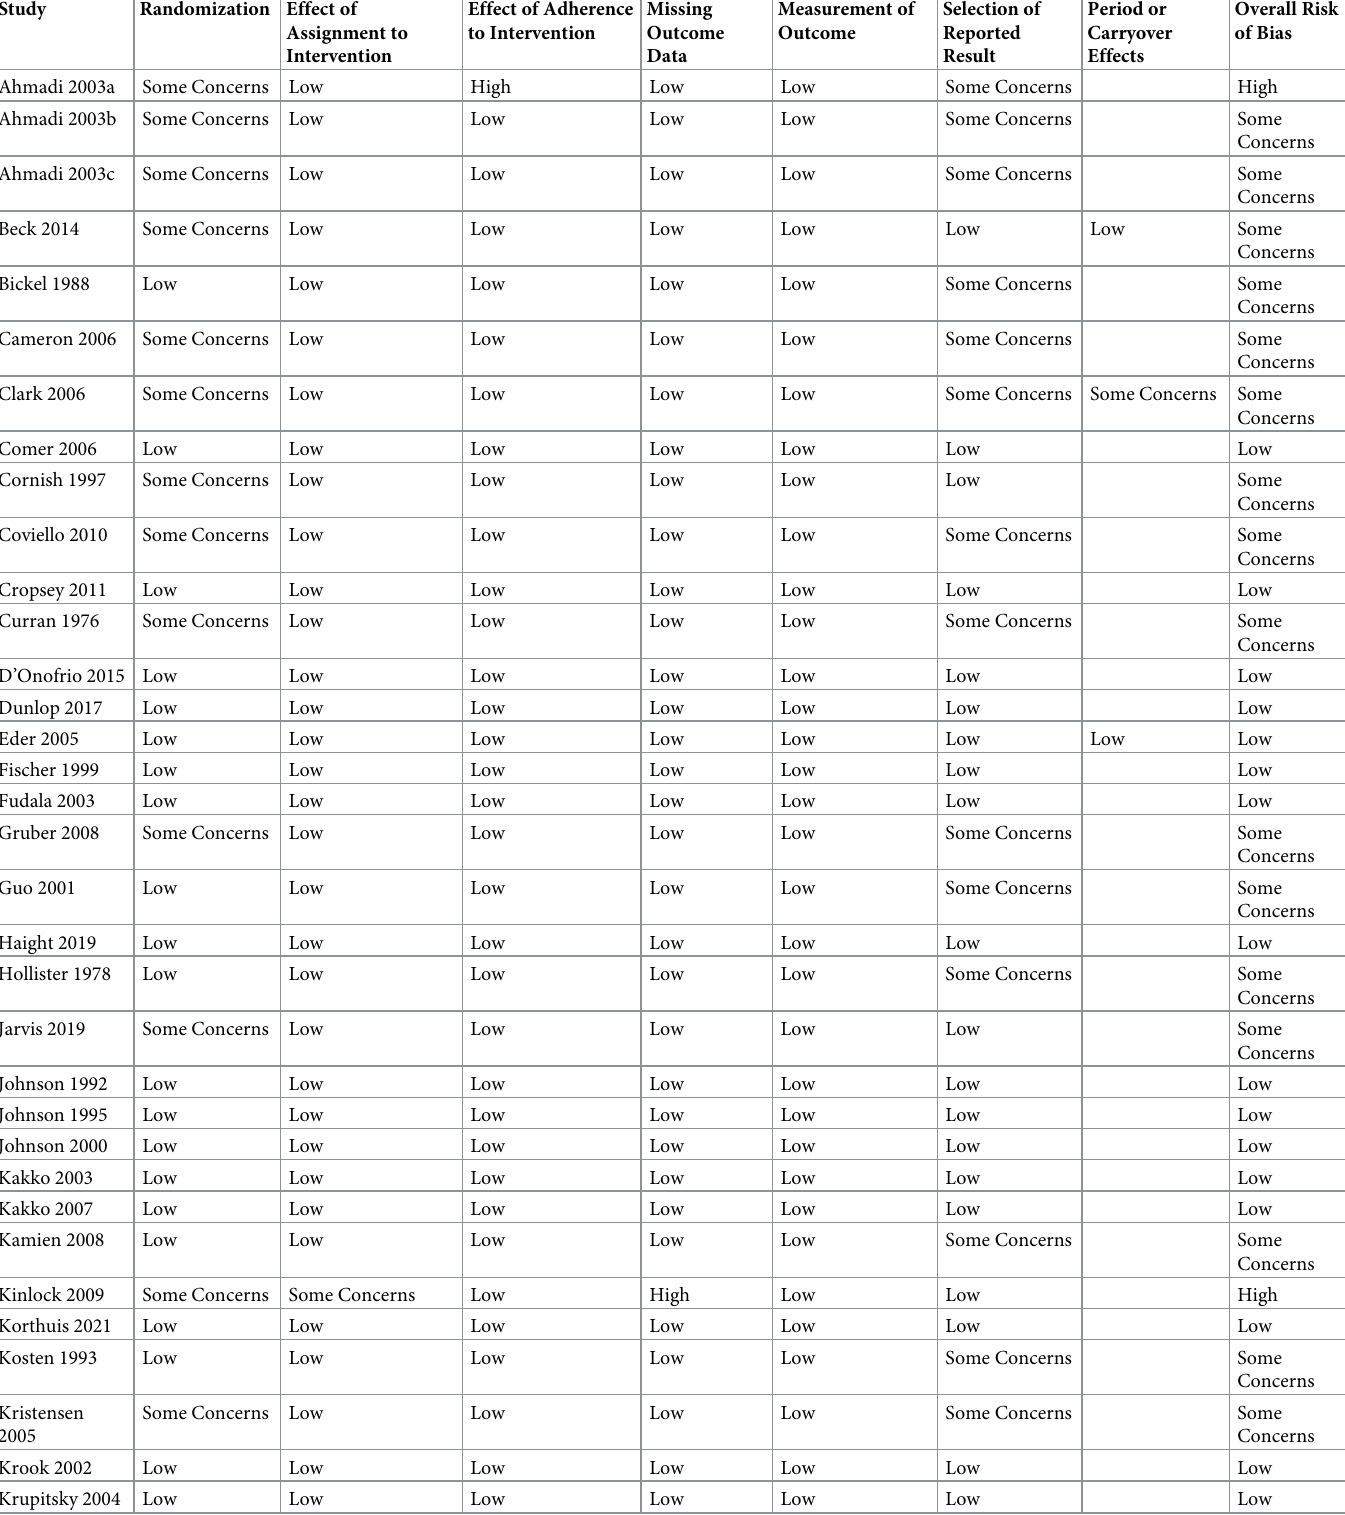
Table 2. Risk of bias